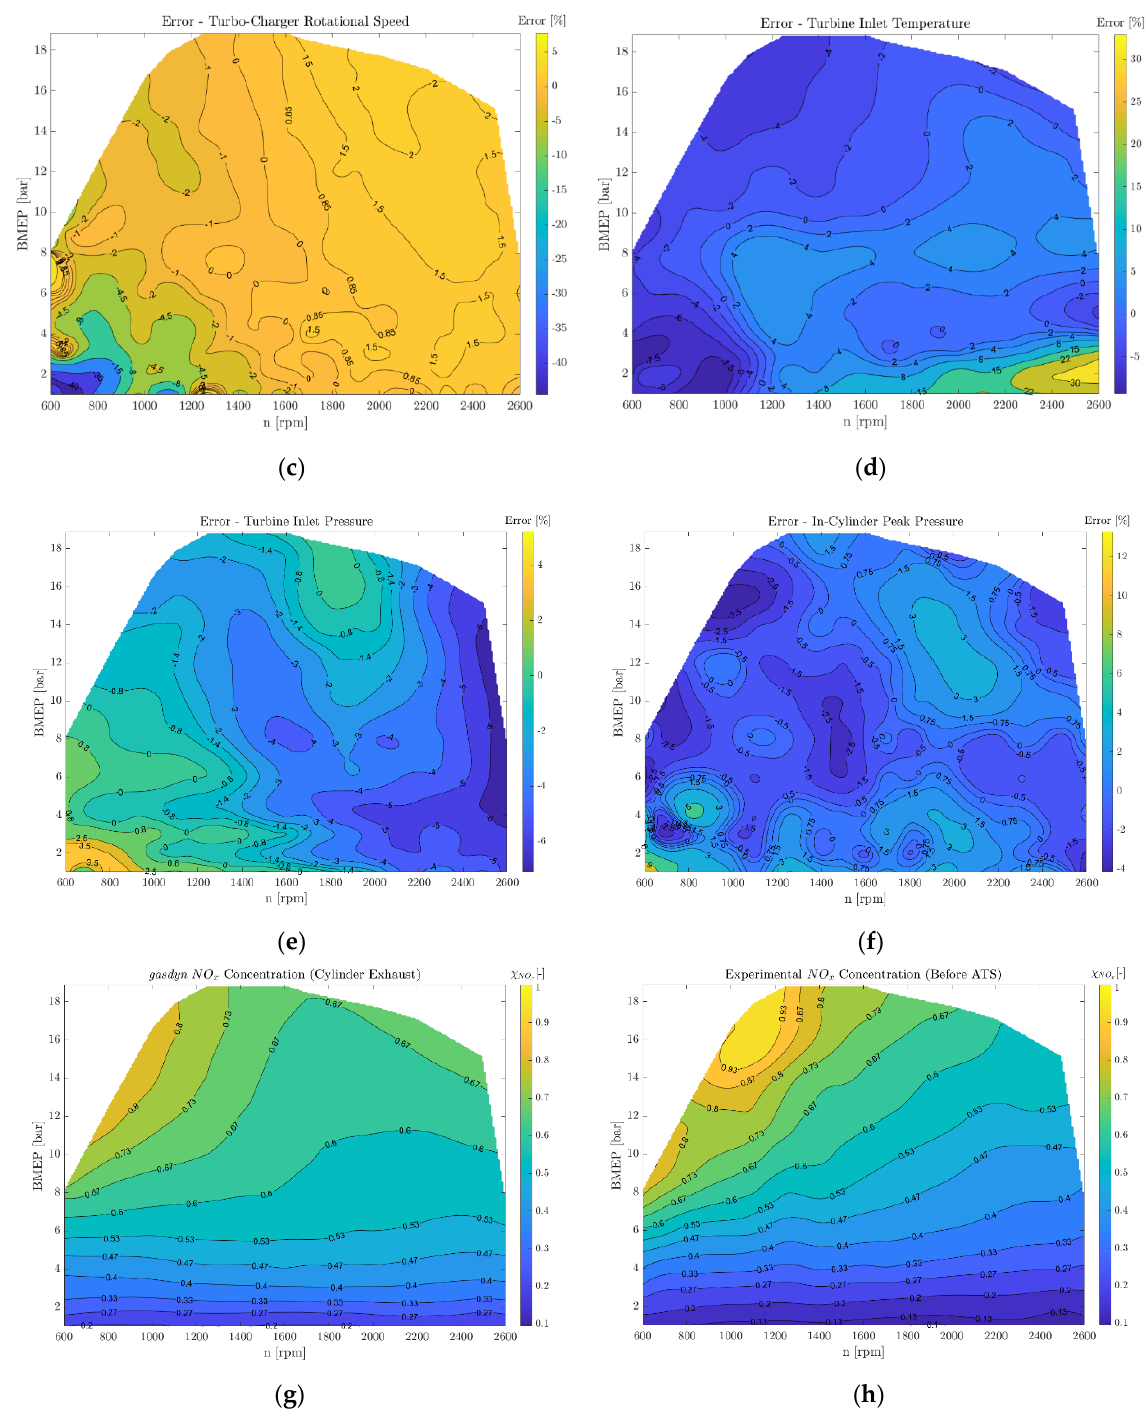
Figure 10. Steady-state maps of the six-cylinder Diesel engine predicted by Gasdyn : ( a ) % error—BSFC; ( b ) % error—air mass flow rate; ( c ) % error—turbocharger Speed; ( d ) % error—turbine inlet temperature; ( e ) % error—turbine inlet pressure; ( f ) % error—cylinder peak pressure; ( g ) cylinder-out NO x concentration (non-dimensional); ( h ) cylinder-out experimental NO x concentration (non-dimensional).